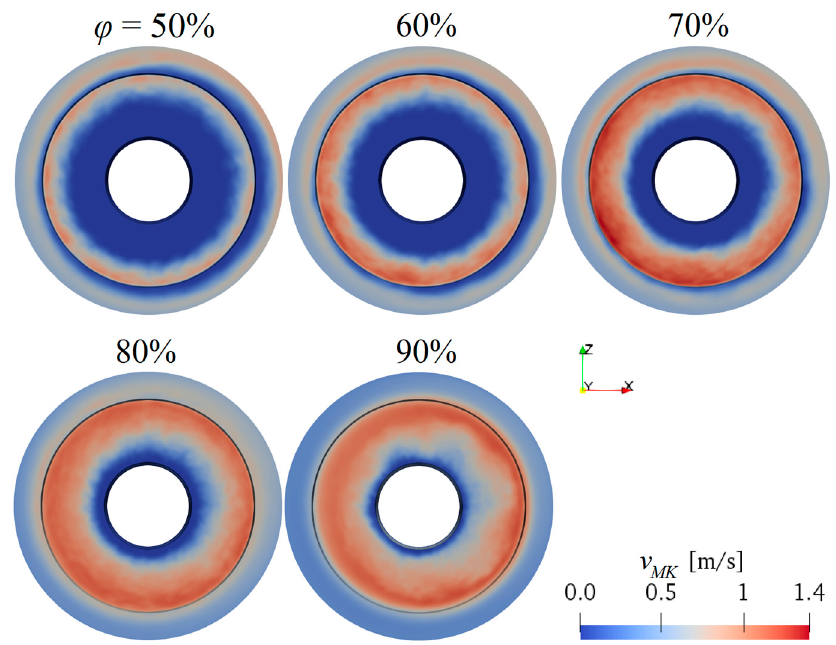
Figure 5. Local average grinding media speed in the radial plan view of the simulation cell for different grinding media filling grades φ at a circumferential speed of v t = 6 m/s.